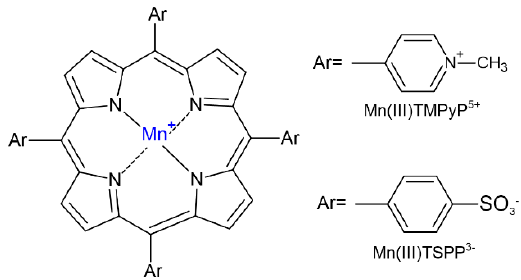
Figure 2. Structures of manganese(III) complexes with cationic 5,10,15,20-tetrakis(1-methyl-4-pyridinium)porphyrin (Mn(III)TMPyP 5+ ) and anionic 5,10,15,20-tetrakis(4-sulfonatophenyl)porphyrin (Mn(III)TSPP 3− ).